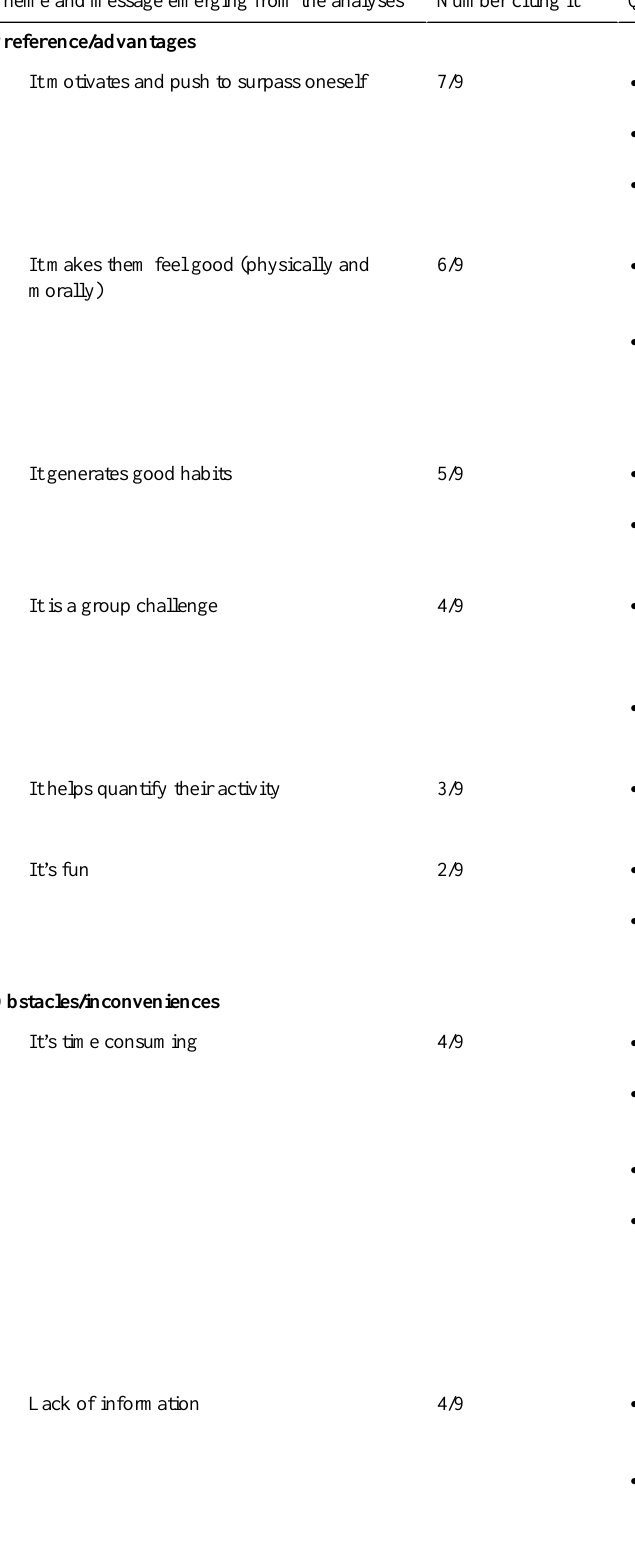
QuotesNumber citing itTheme and message emerging from the